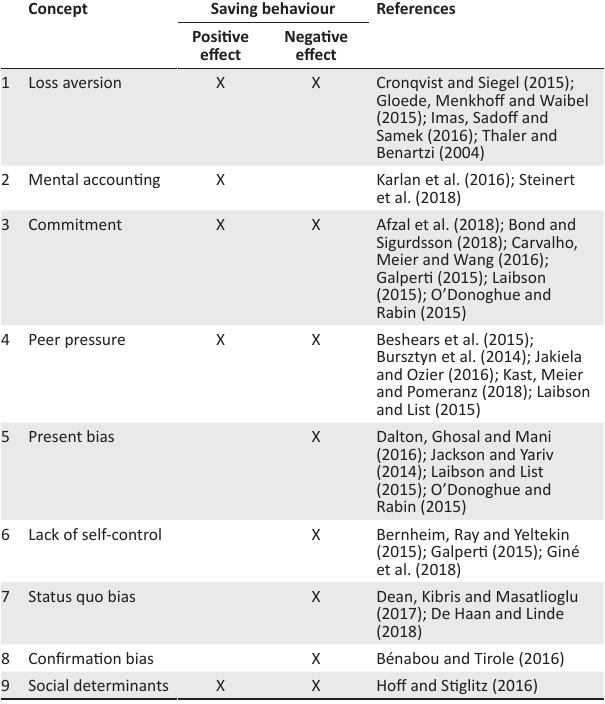
TABLE 1: Saving behaviour in a behavioural economics context.